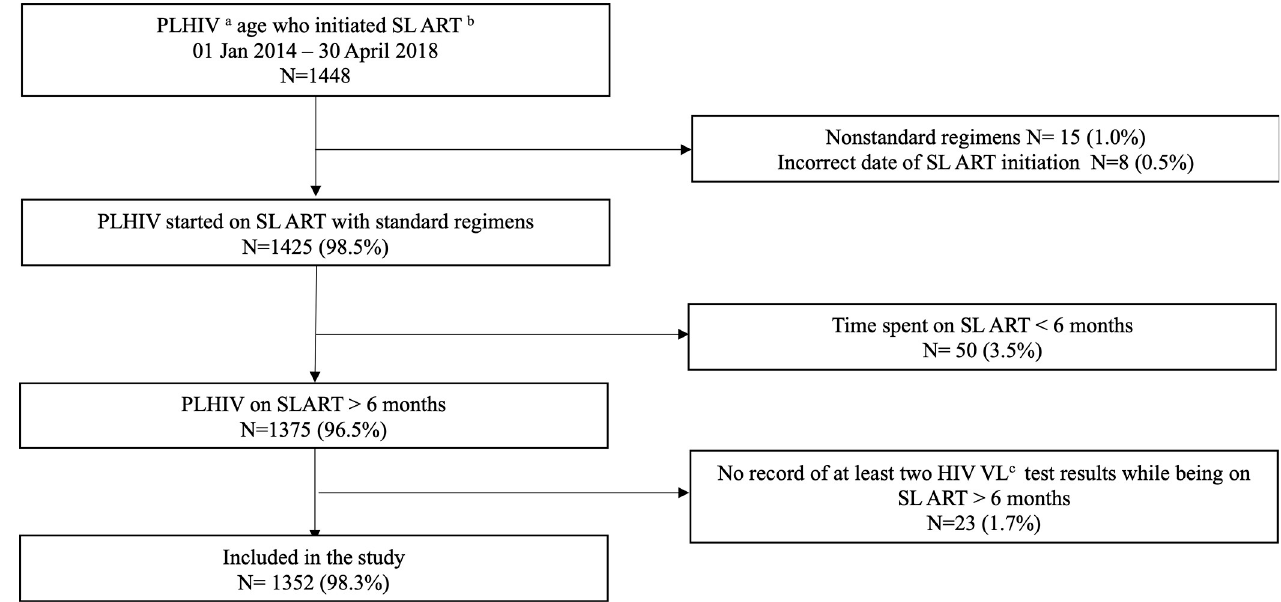
Fig 2. Flowchart for inclusion of participants in the study. a PLHIV: People living with HIV, b SL ART: Second-line antiretroviral treatment, c HIV VL: HIV viral load. https://doi.org/10.1371/journal.pone.0271910.g002 PLOS ONE | https://doi.org/10.1371/journal.pone.0271910 July 29,